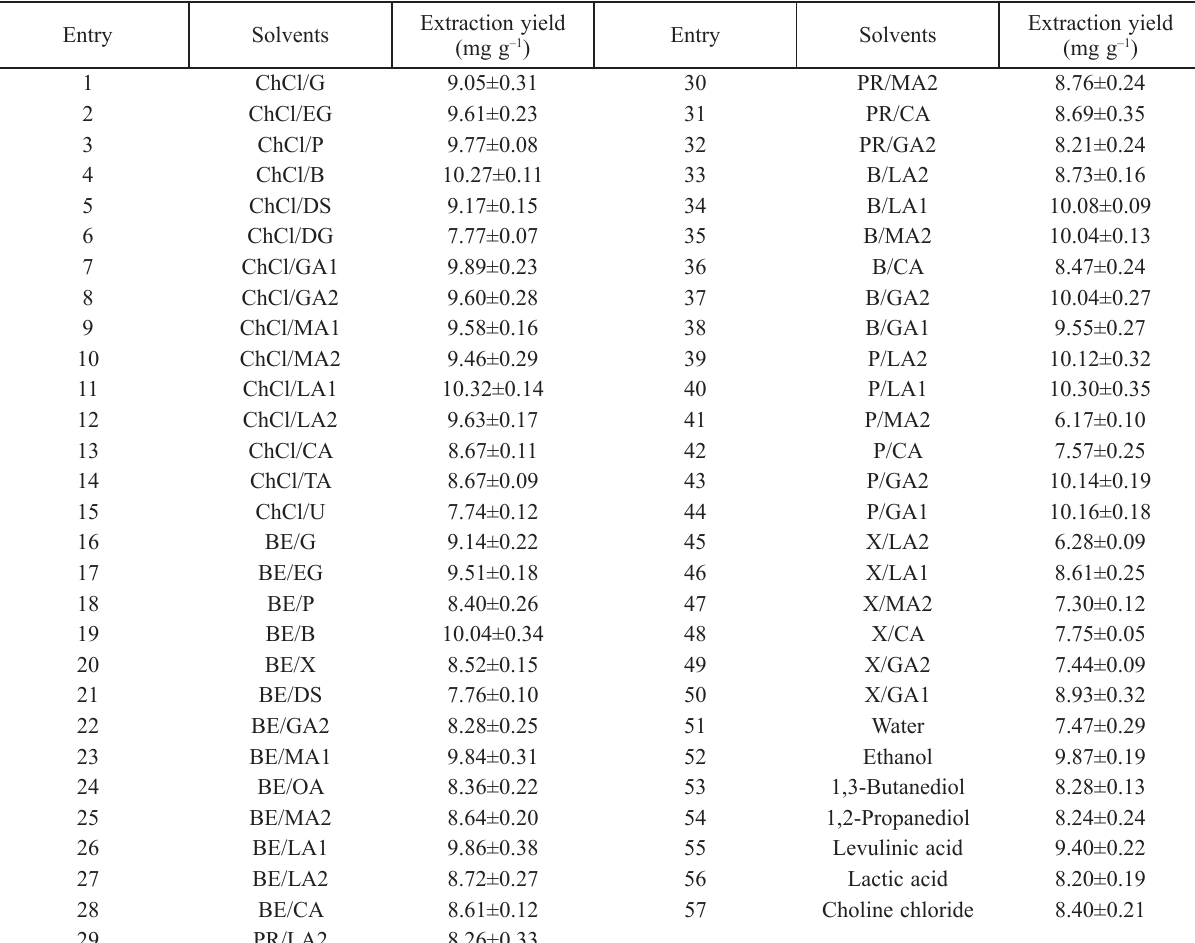
Table 2 – Amount of flavonoids extracted from Ginkgo biloba leaves using different DESs and reference solvents a